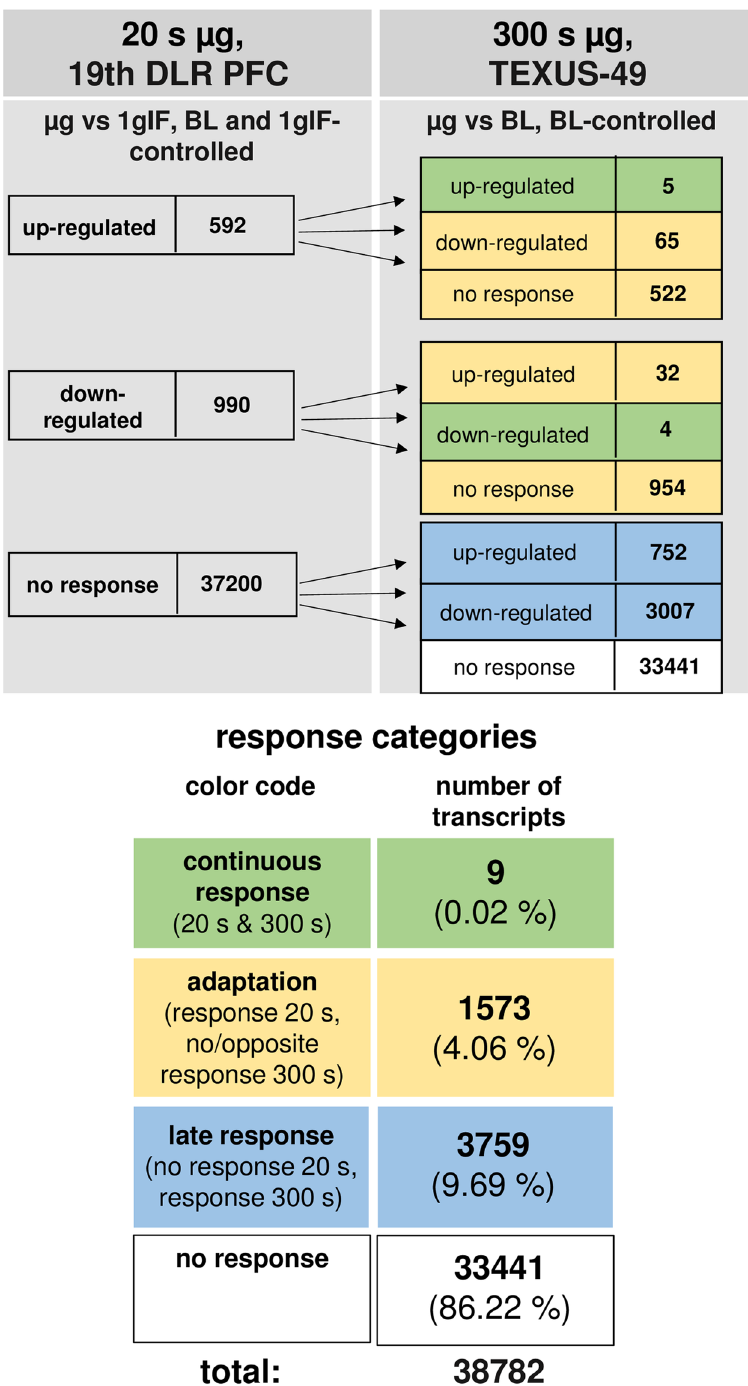
Figure 11. Time course of differential gene expression in microgravity. Human myelomonocytic U937 cells were exposed to 20 s and 300 s of microgravity. The numbers of annotated transcripts grouped according to their regulation after the two exposure times are shown. Continuous response means that annotated transcript are either up- or down-regulated at both time points. Adaption is either disappearance of the microgravity induced effect or regulation in the opposite direction after 300 s. Late response is a regulation that only appears after 300 s. Most transcripts did not respond to microgravity at both time